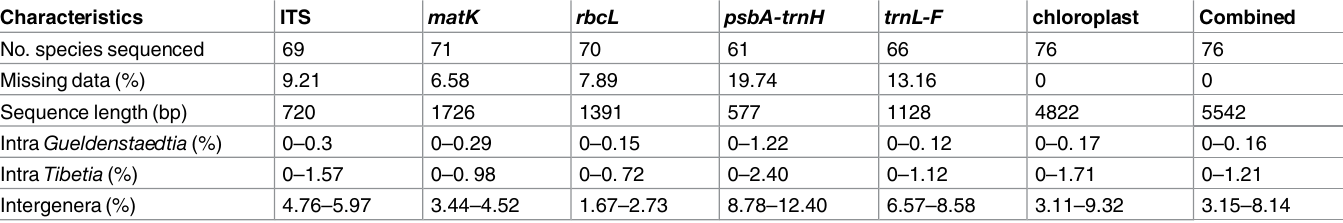
Table 2. Sequencecharacteristicsof Tibetia and Gueldenstaedtia ,and sequencedivergence values, which were estimatedwithpairwise distance.